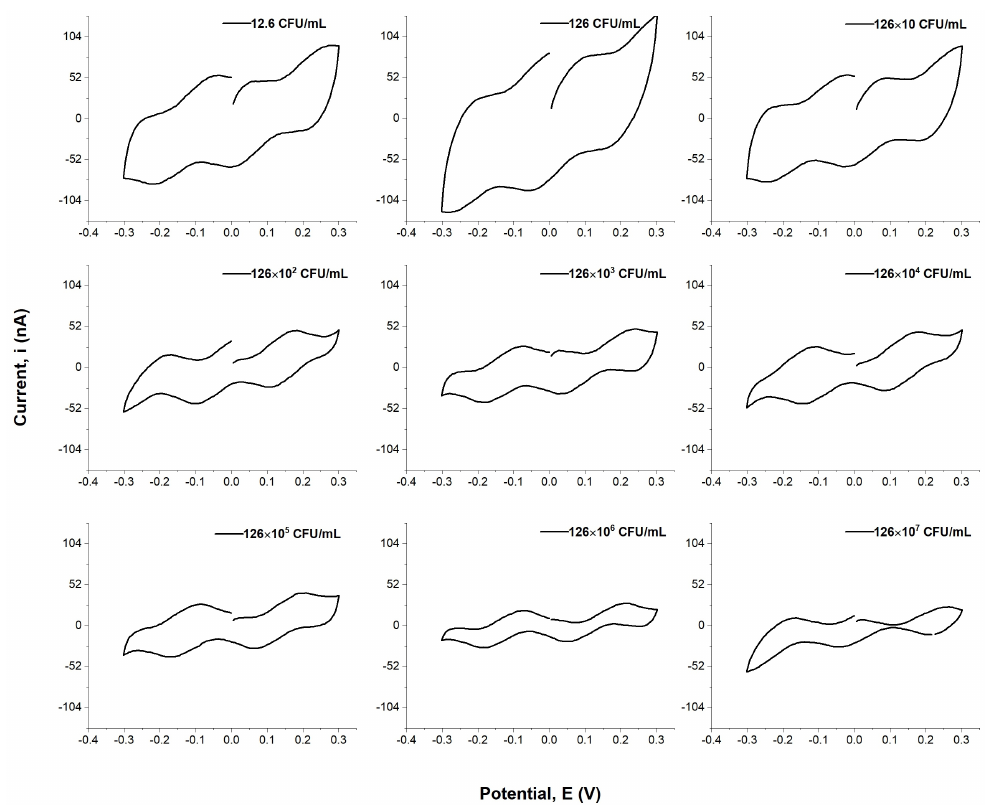
Figure 5. Cyclic voltammogram curves at different E. coli